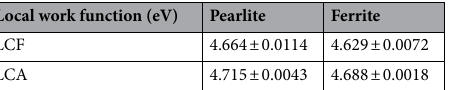
Table 2. Statistical local work function in LCF and LCA